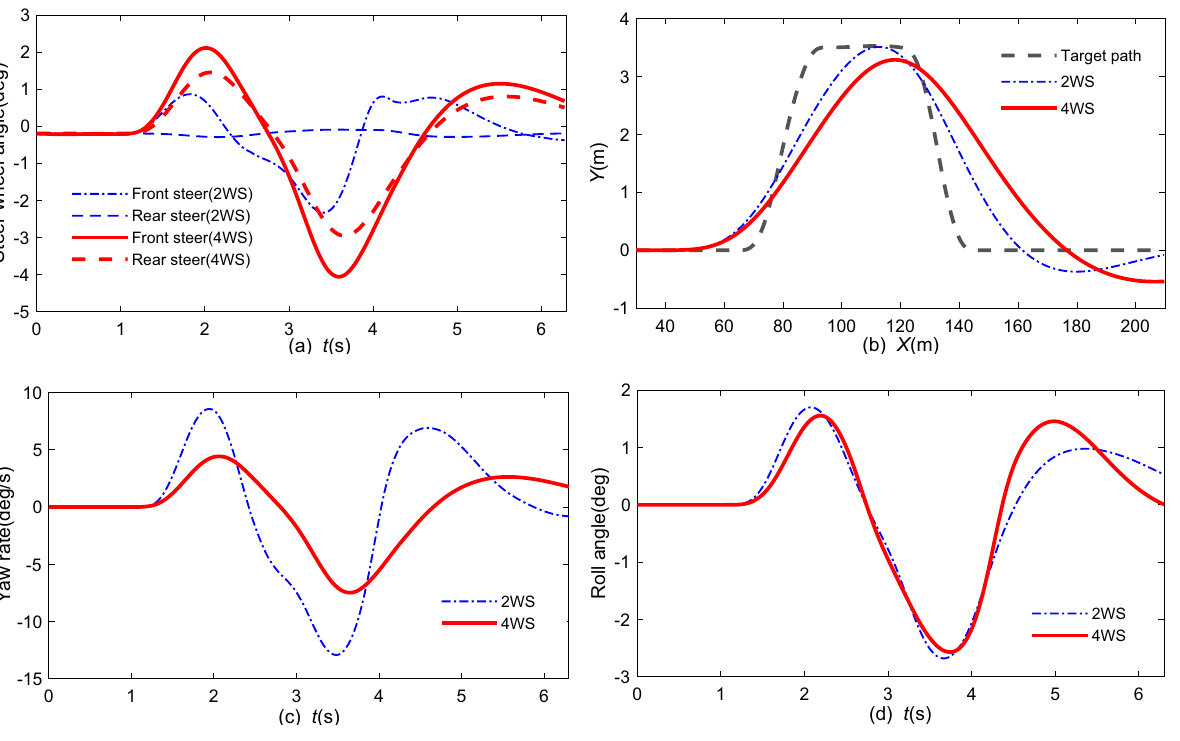
Figure 10. Simulation comparison with 4 WS under the DLC condition: ( a ) front, rear wheel steering angle; ( b ) lateral position; ( c ) yaw rate; ( d ) roll angle.